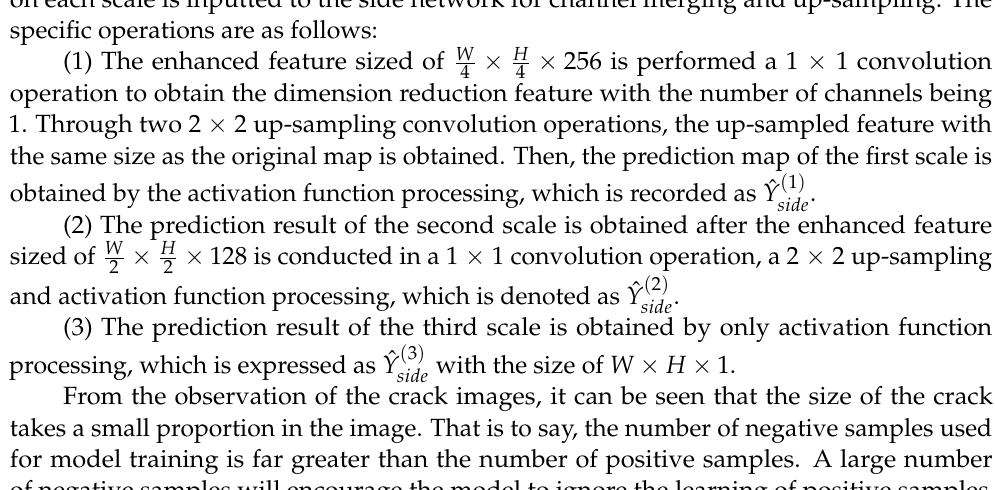
Figure 6. Feature map before and after the morphological network processing: ( a ) original image, ( b ) ground truth, ( c ) feature map before morphological processing, ( d ) feature map after morphological processing.